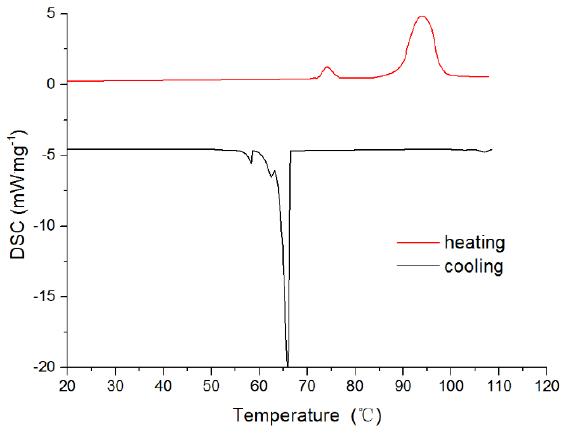
Table 1. Thermal properties for MNH and MNH90.